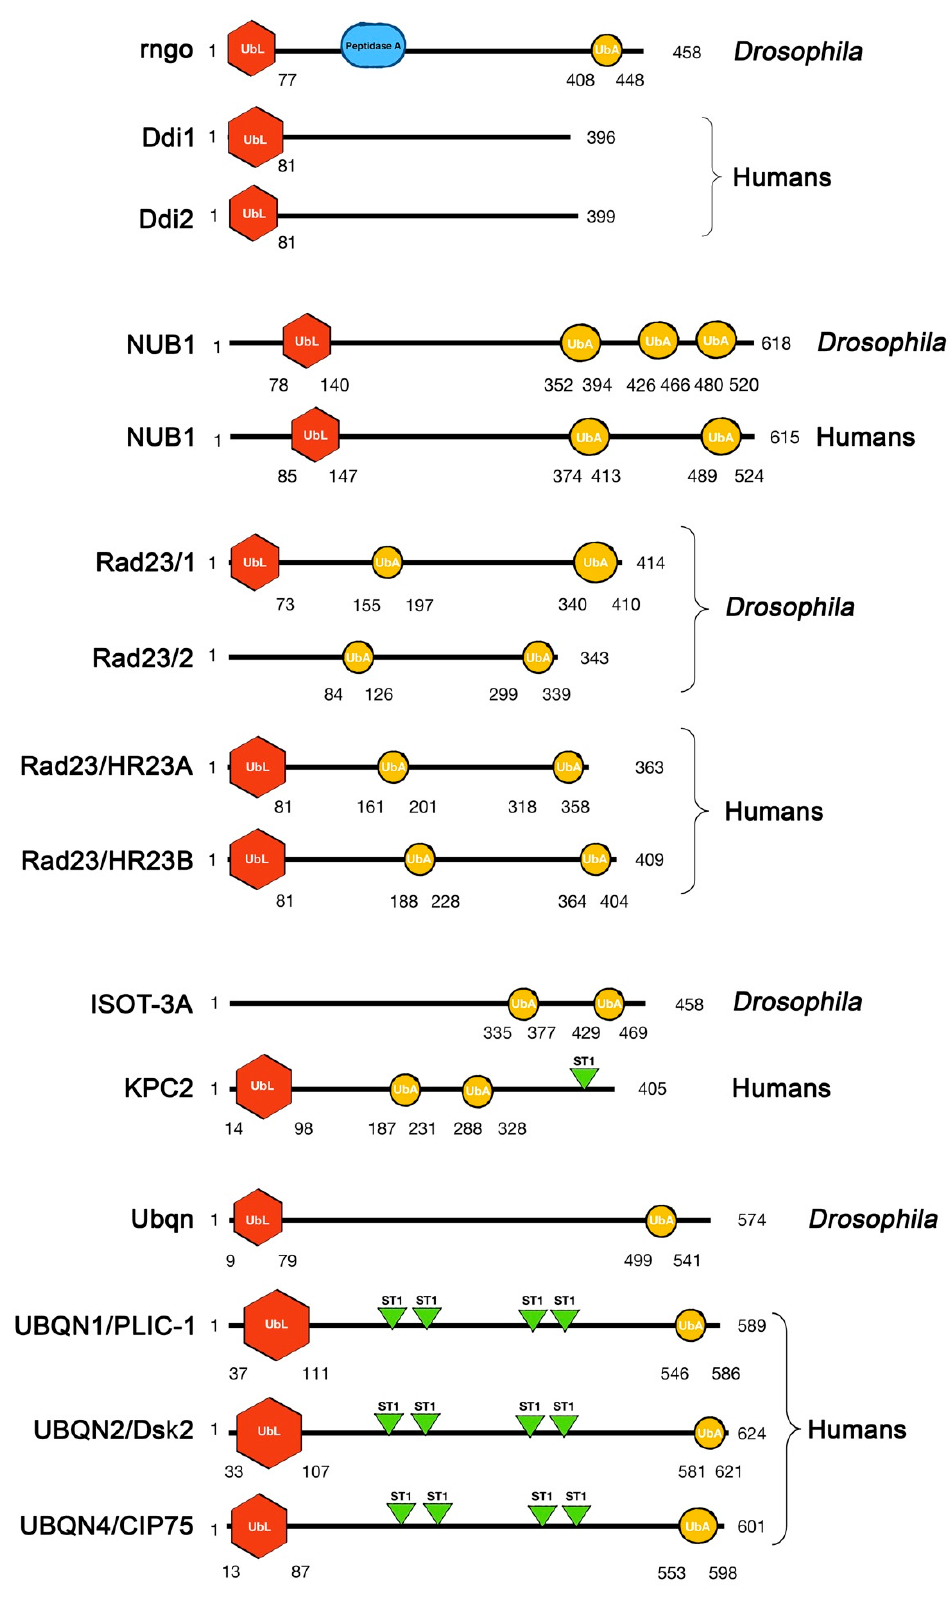
Figure 2. Comparison of Drosophila and human UbL-UbA proteins.